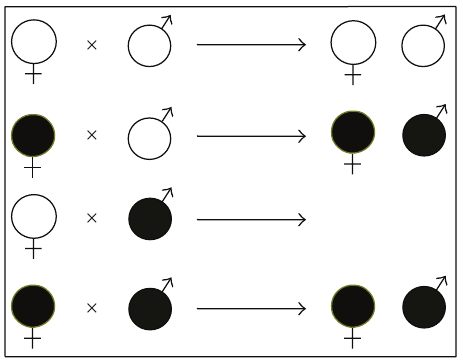
Figure 1: Cytoplasmatic incompatibility induced by Wolbachia